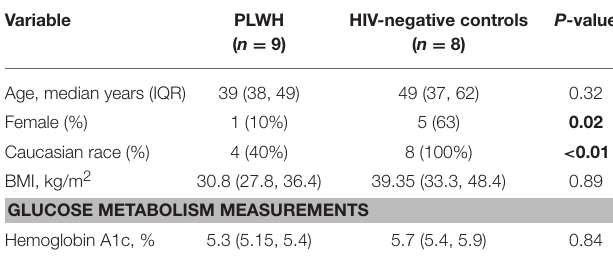
TABLE 2 | Comparison of HIV-negative participants and comparator non- and pre-diabetic PLWH.